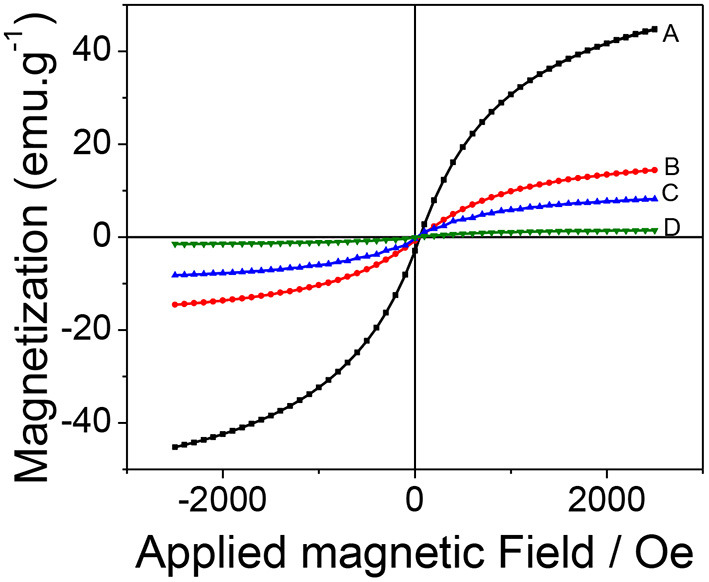
Magnetization hysteresis curves: (A) Fe3O4, (B) Fe3O4@SiO2, (C) Fe3O4@MPS, and (D) mag-MIP.